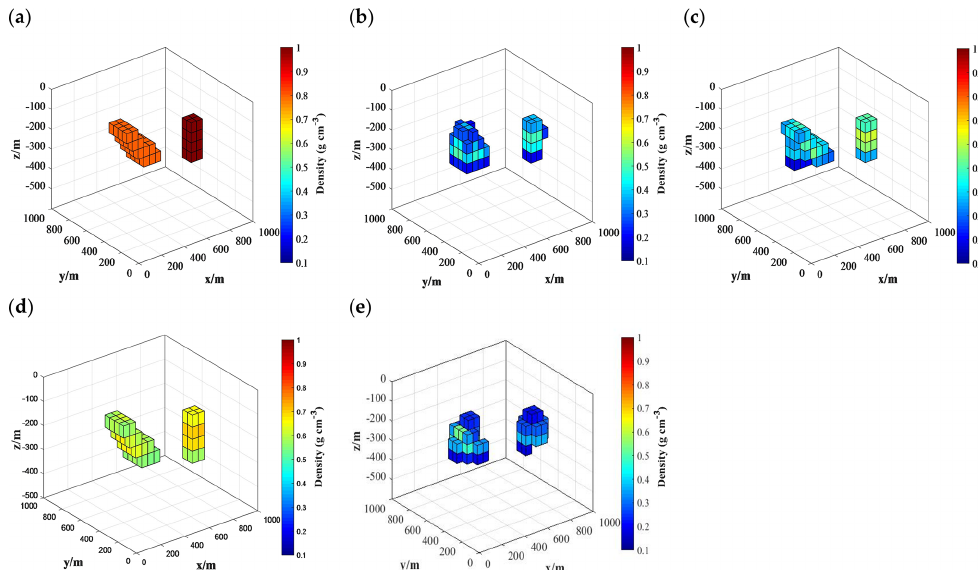
Figure 3. Initial density experiment model 2. (a) True model. Inversion results for (b ) test 1, (c ) test 2, (d ) test 3 and (e ) Test 4.